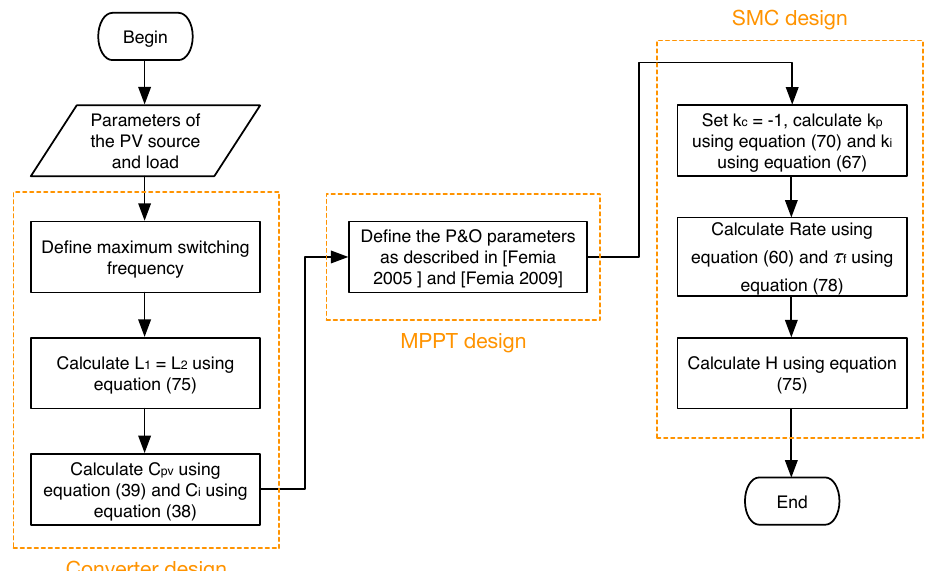
Figure 10. Flowchart of the proposed design process, where the P&O parameters are defined following